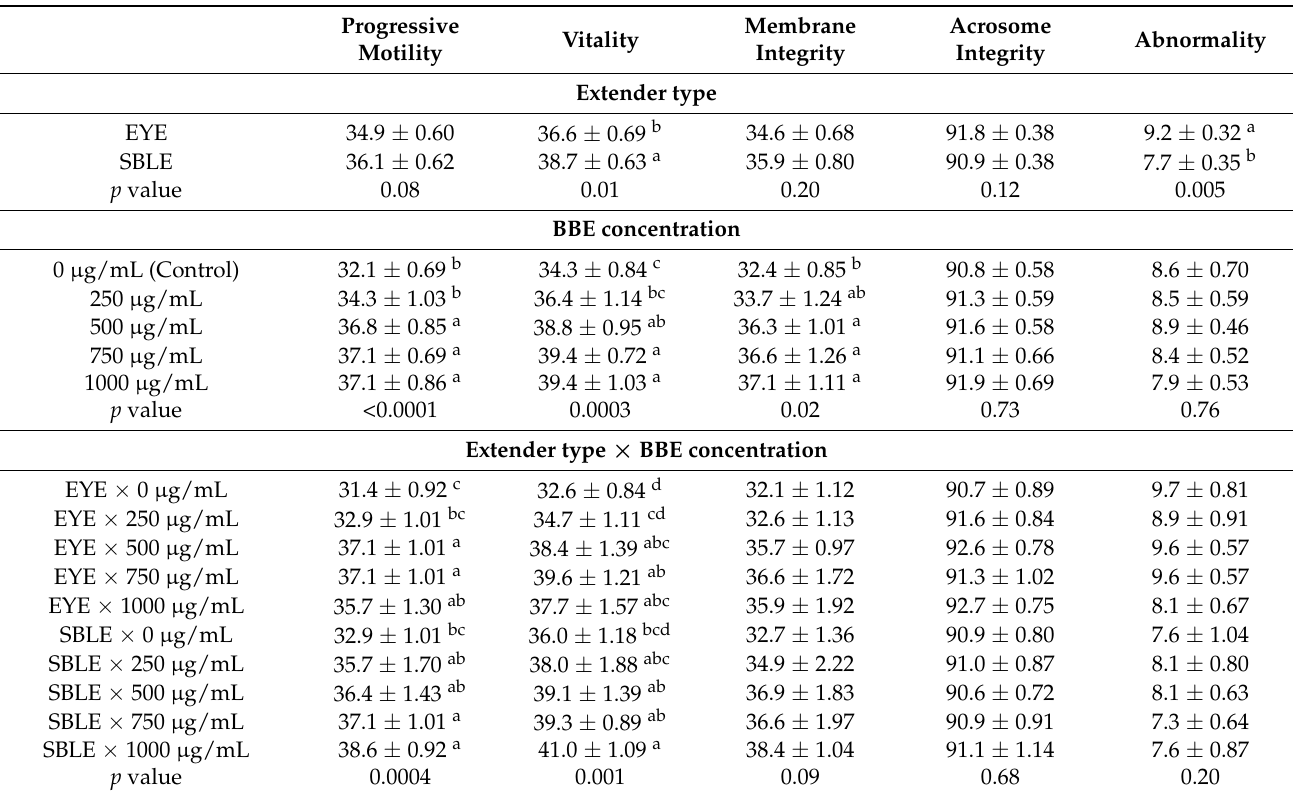
Table 3. Effects of the extender type, bee bread extract (BBE) concentration, and their interaction on the proportion (%) of ram sperm characteristics after thawing.